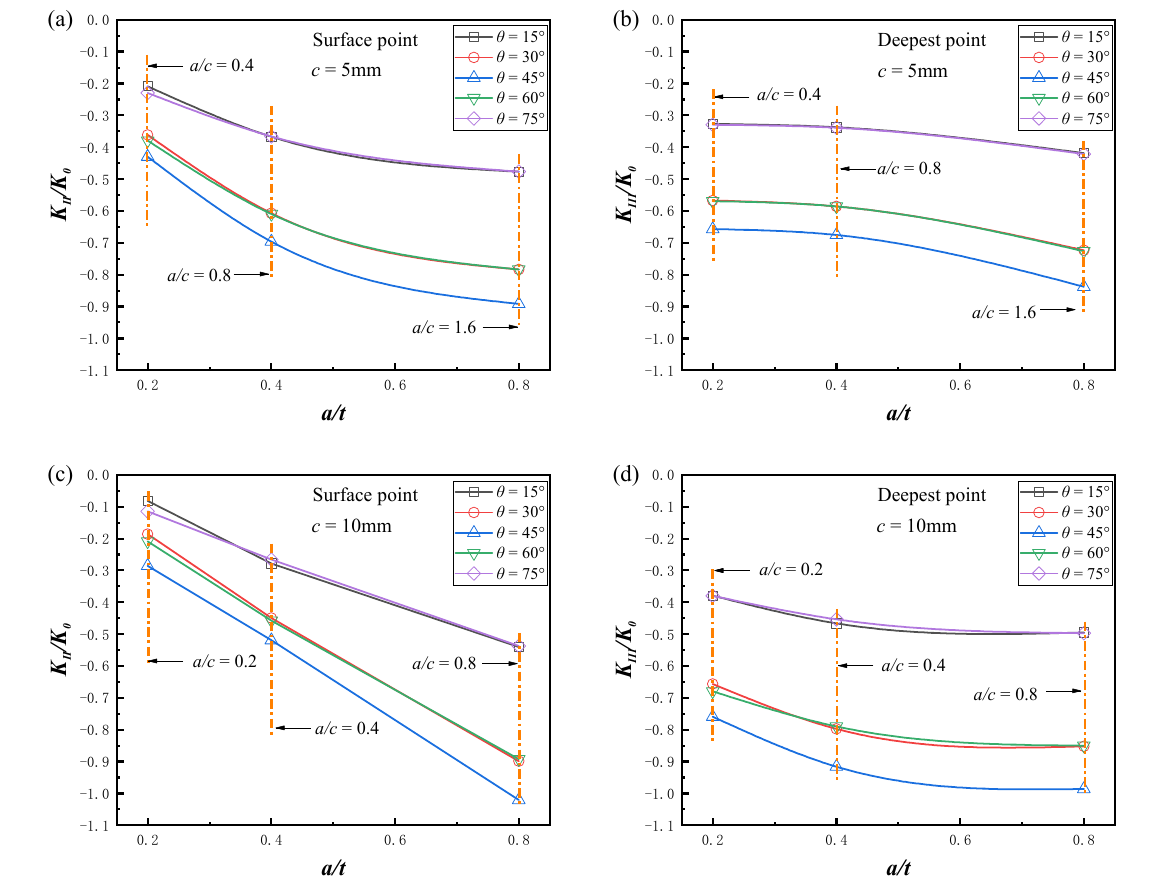
Figure 8. Effect of the relative depth on the normalized SIFs, µ = 0. ( a ) Normalized K II ( c = 5 mm, a/c = 0.4, 0.8, 1.6); ( b ) normalized K III ( c = 5 mm, a/c = 0.4, 0.8, 1.6); ( c ) normalized K II ( c = 10 mm, a/c = 0.2, 0.4, 0.8); ( d ) normalized K III ( c = 10 mm, a/c = 0.2, 0.4, 0.8).